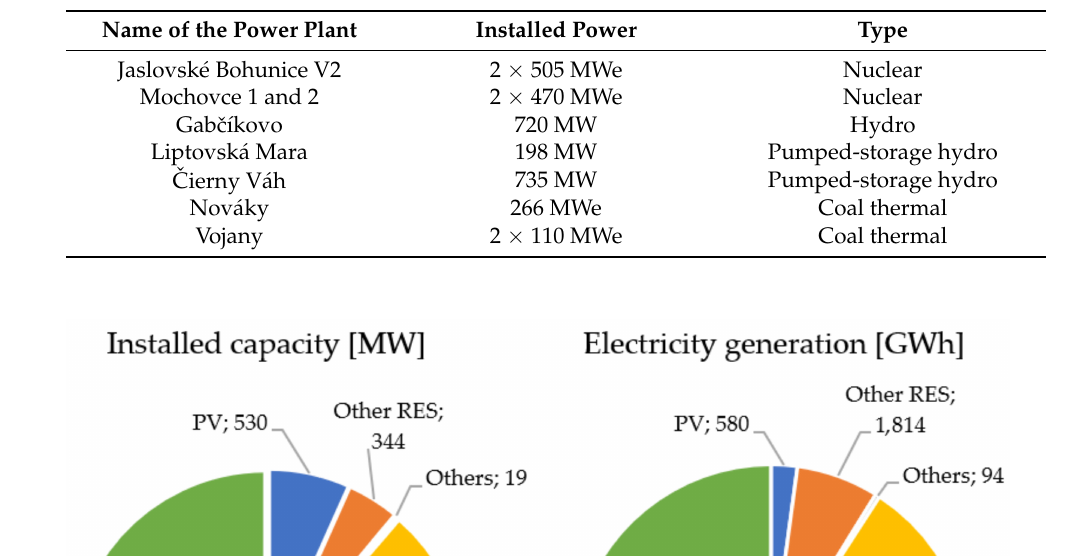
Table 1. Key power plants in the Slovak Republic.